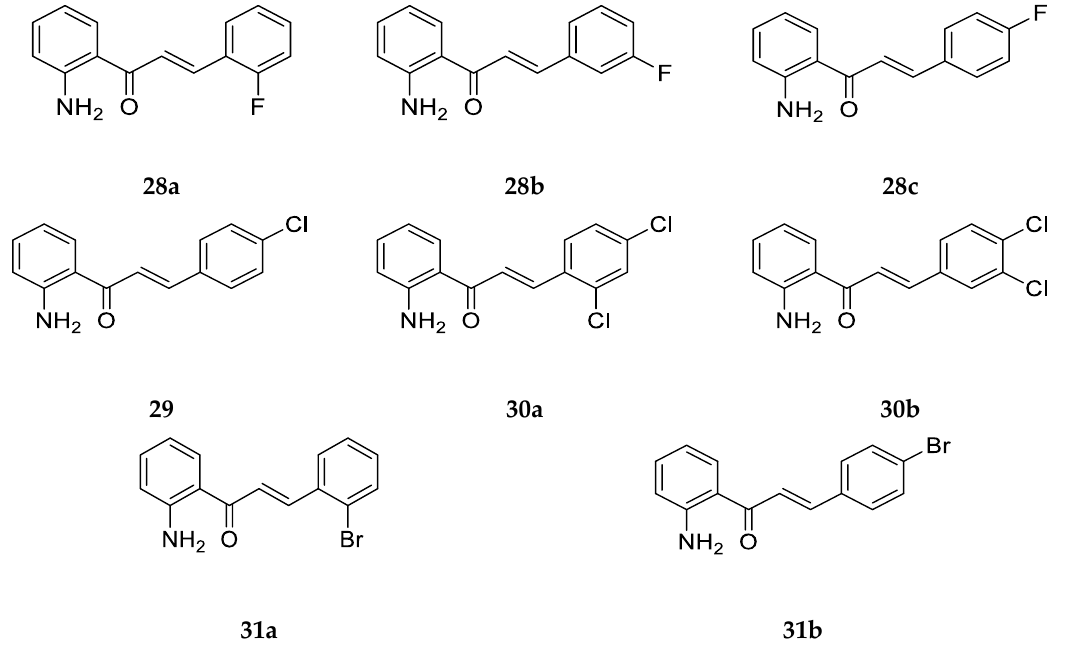
Figure 23. Chemical structures of derivatives of 2-aminochalcone with halogen substitution on ring B.